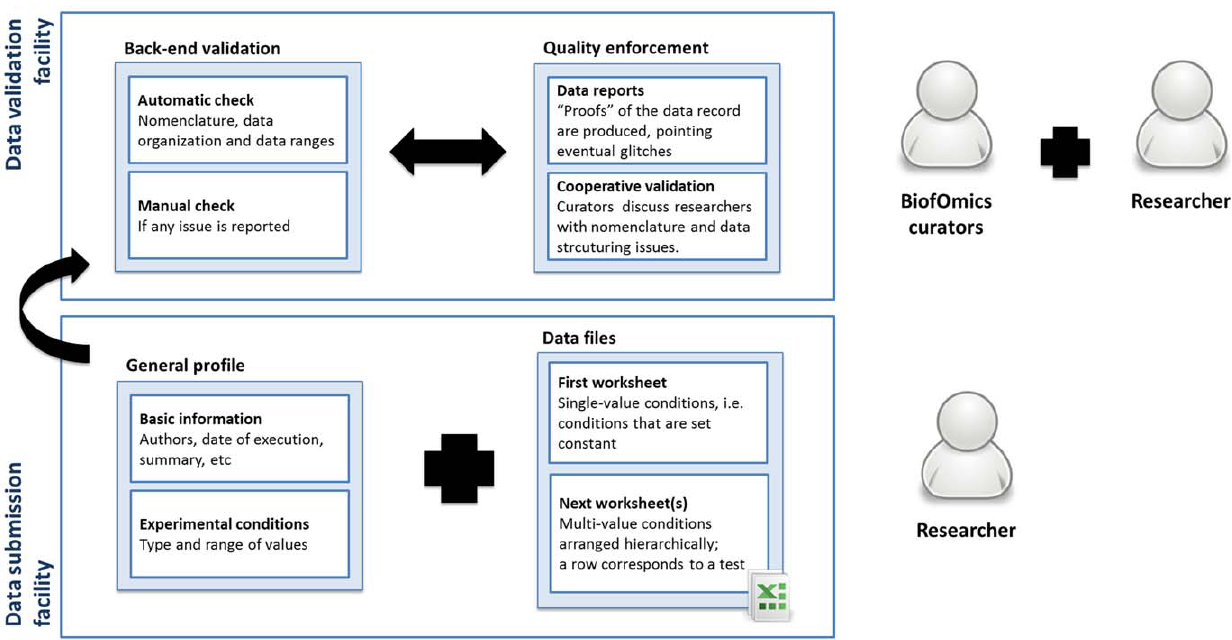
Figure 3. Data submission process: the data submission facility allows researchers to submit files arranged in a certain format, containing a minimum set of information. Researchers and curators work together in order to validate and ensure the quality of the submission.